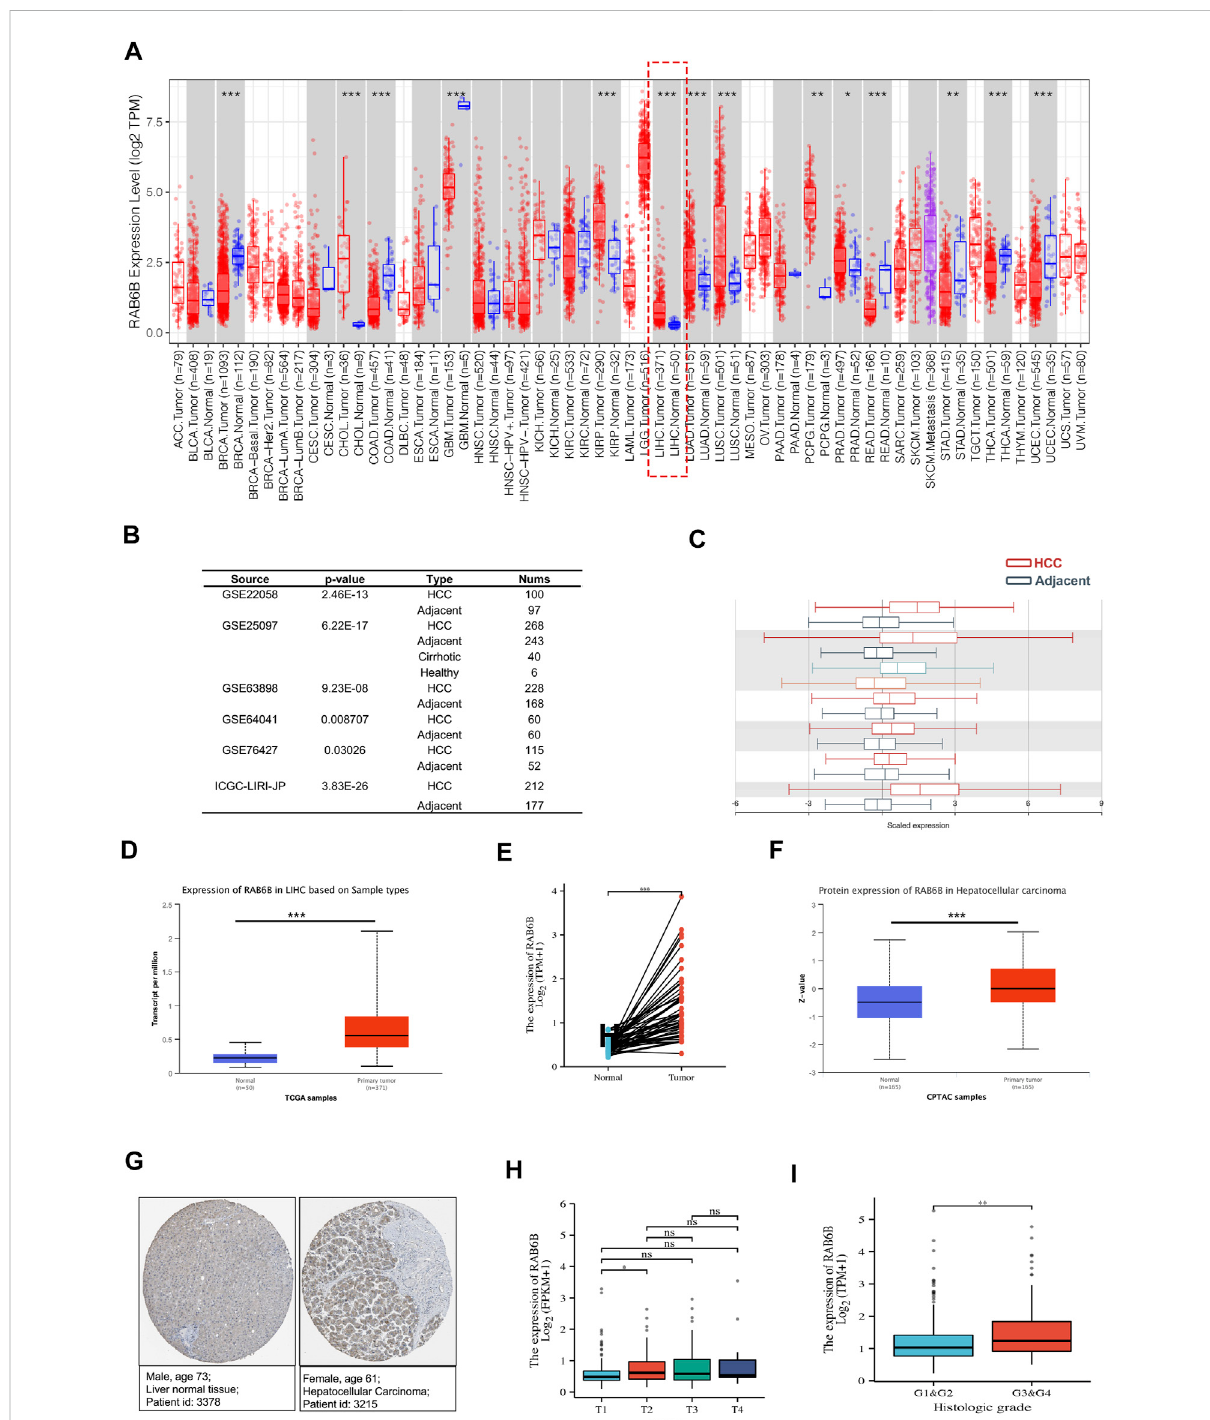
FIGURE 1 The expression level of RAB6B in HCC tissues. (A) RAB6B expression level in various tumor tissues and corresponding normal tissues in the TIMER2.0 database. RAB6B was upregulated in liver hepatocellular carcinoma (LIHC). * p < 0.05, ** p < 0.01, and *** p < 0.001. (B,C) RAB6B was highly expressed in HCC tissues compared to the adjacent liver tissues in six HCC cohorts from the HCCDB database. (D) RAB6B mRNA expression level was increasedinHCC tissues comparedto normal liver tissuesbasedonthe UALCAN database. *** p < 0.001. (E) RAB6Bexpression washigher in 50 HCC tissuesthanintheirpairedadjacentnormallivertissuesbasedontheTCGAdatabase.*** p < 0.001. (F) RAB6BproteinlevelinHCCtissuesandnormaltissues were obtained from the CPTAC dataset. *** p < 0.001. (G) Representative immunohistochemistry (IHC) images of RAB6B in HCC tissues (right image) and normallivertissues(leftimage)fromtheHPAdatabase. (H) BoxplotindicatedthatRAB6Bexpressionwassigni fi cantlyassociatedwithHCCpatients ’ Tstage. * p < 0.05, ns = no signi fi cance. (I) Boxplot showed that RAB6B expression was correlated with histologic grade. ** p <